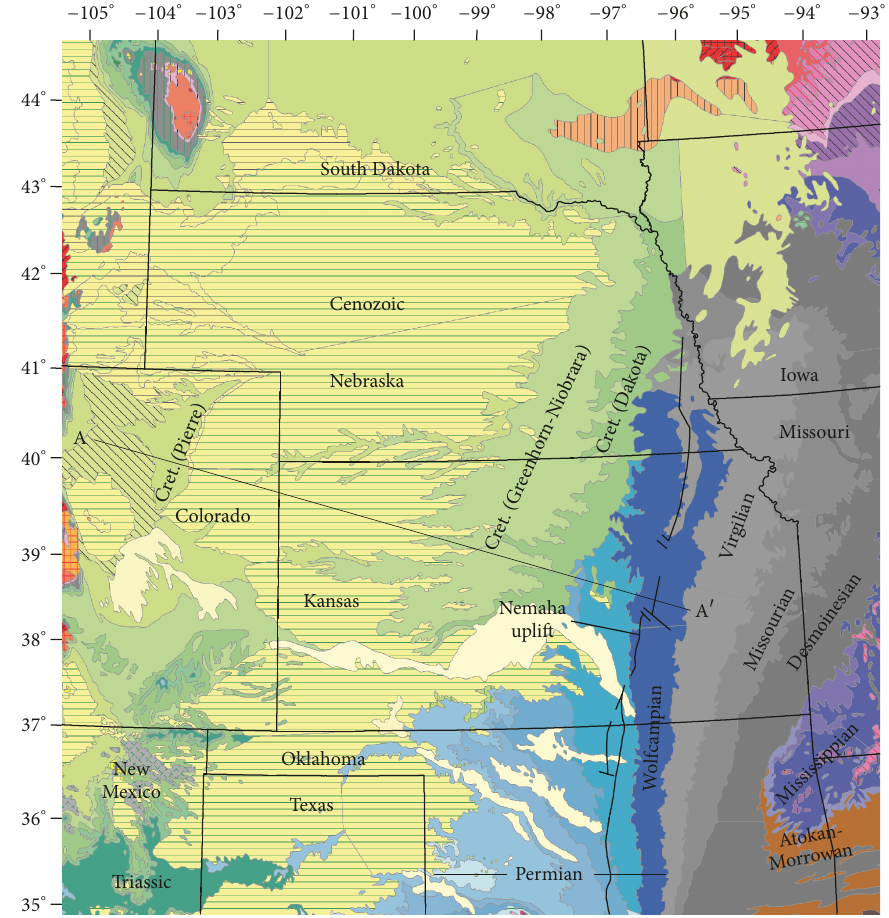
Figure 6: Geologic map of study area from Nelson et al. ([7], Figure 4 ) with the 800 km cross-section A-A 󸀠 .